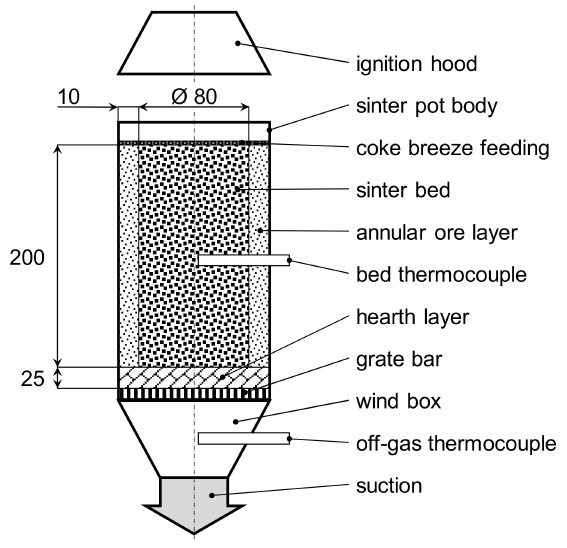
Figure 1. Sinter pot arrangement (dimensions in